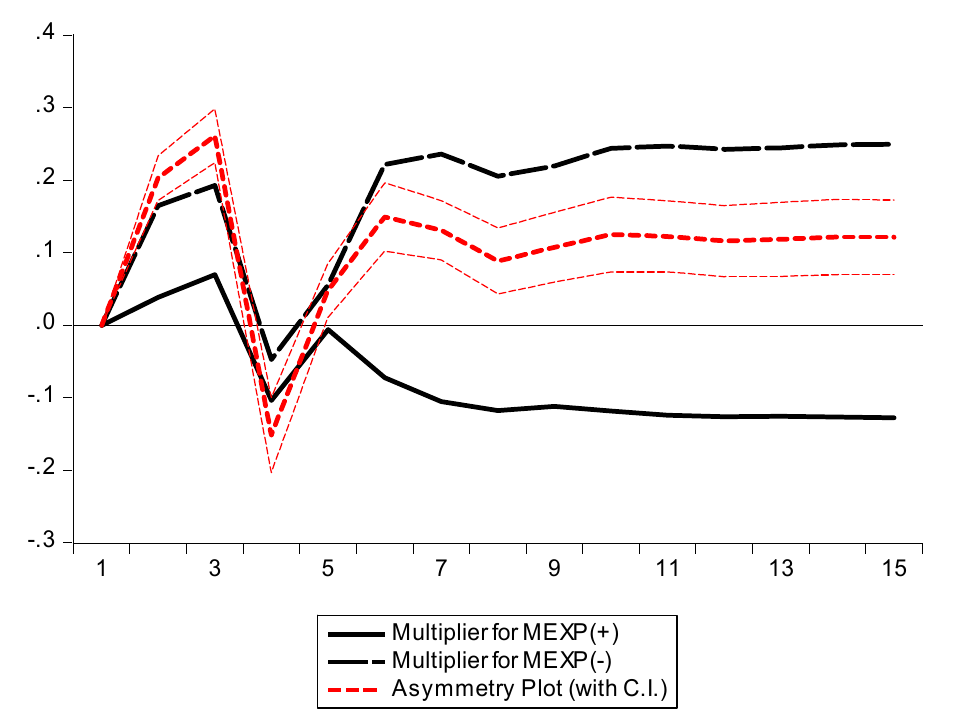
Figure 2. Asymmetric arms transfers plots. Source: author’s estimate. Note: AIMP + and AIMP − shows positive and negative shocks in arms imports, AFP + and AFP − shows positive and negative shocks in armed forces personnel, and MEXP + and MEXP − shows positive and negative shocks in military expenditures.